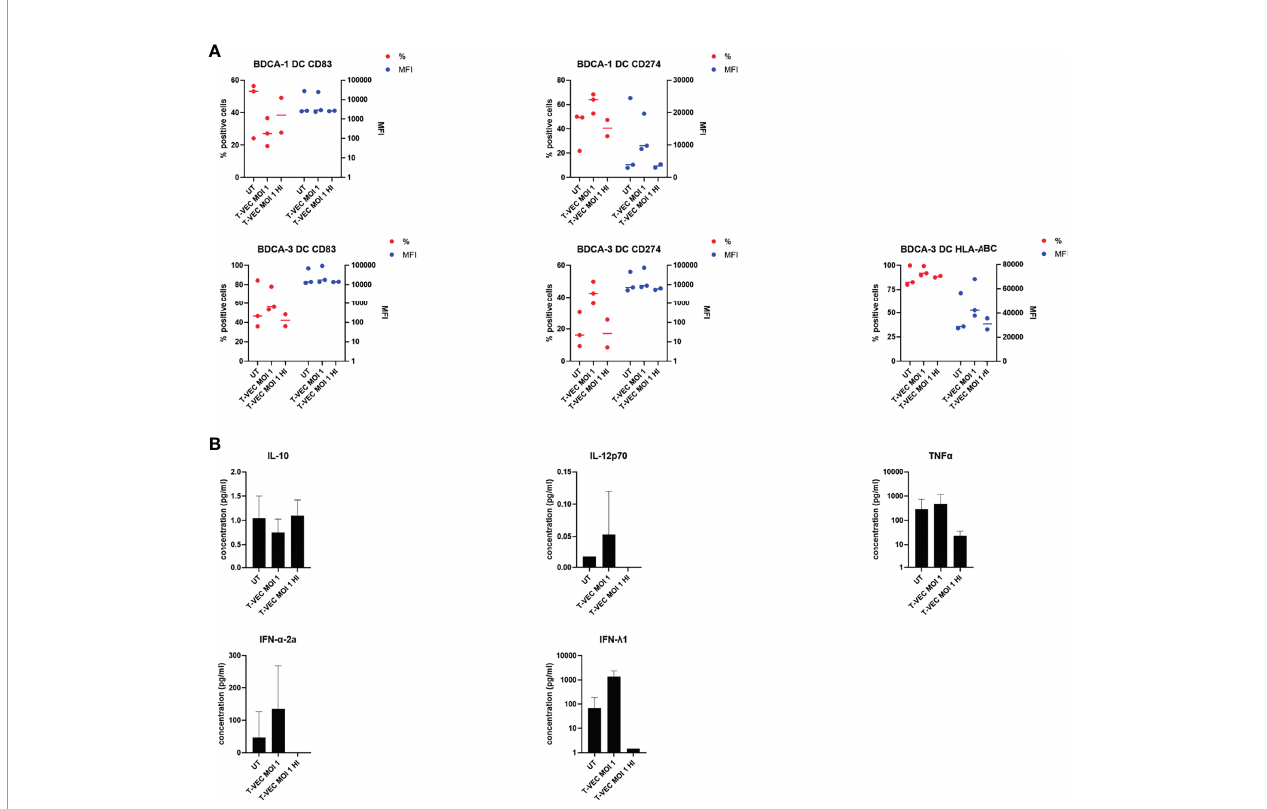
FIGURE 3 | Effect of T-VEC on puri fi ed BDCA-1 + /BDCA-3 + myDC. (A) BDCA-1 + /BDCA-3 + myDC were incubated with T-VEC (MOI 1), heat-inactivated T-VEC (MOI 1) or left untreated. After 24h, the phenotype of the DC was analyzed by fl ow cytometry. On the left y-axis (red symbols) the percentage of expression of each marker is depicted and on the right y-axis (blue symbols) the mean fl uorescence intensity (MFI) is plotted. Each symbol represents the result of an independent experiment and the line represents the median. (B) On the supernatants from the cultures described in (B) , cytokine content was analyzed using MesoScale Diagnostics assays. The graphs depict mean values ± SD and represent data from 3 independent experiments. For IL-12p70, some values were